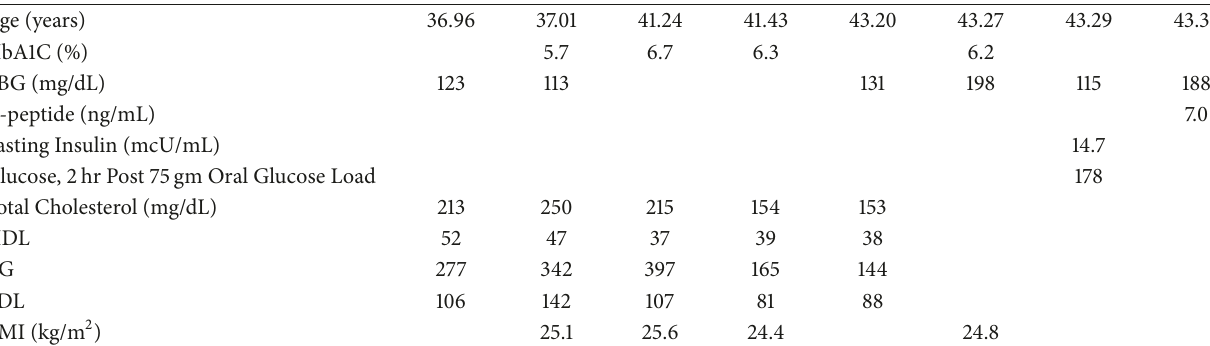
Table 2: Patient laboratory data over